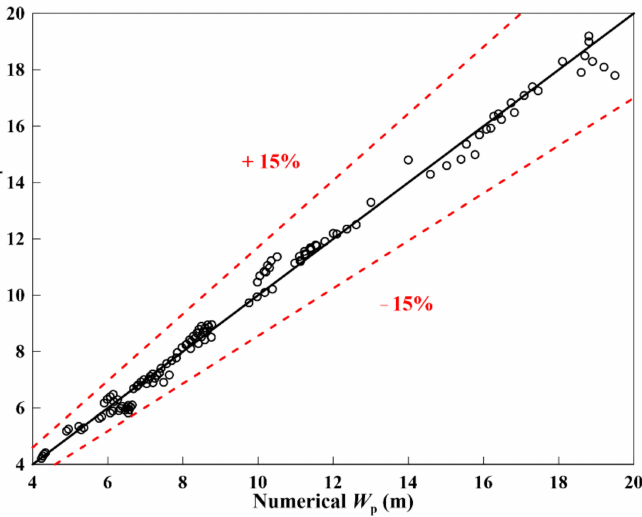
Figure 14. A comparison between the numerical results and the model-predicted results using the presented